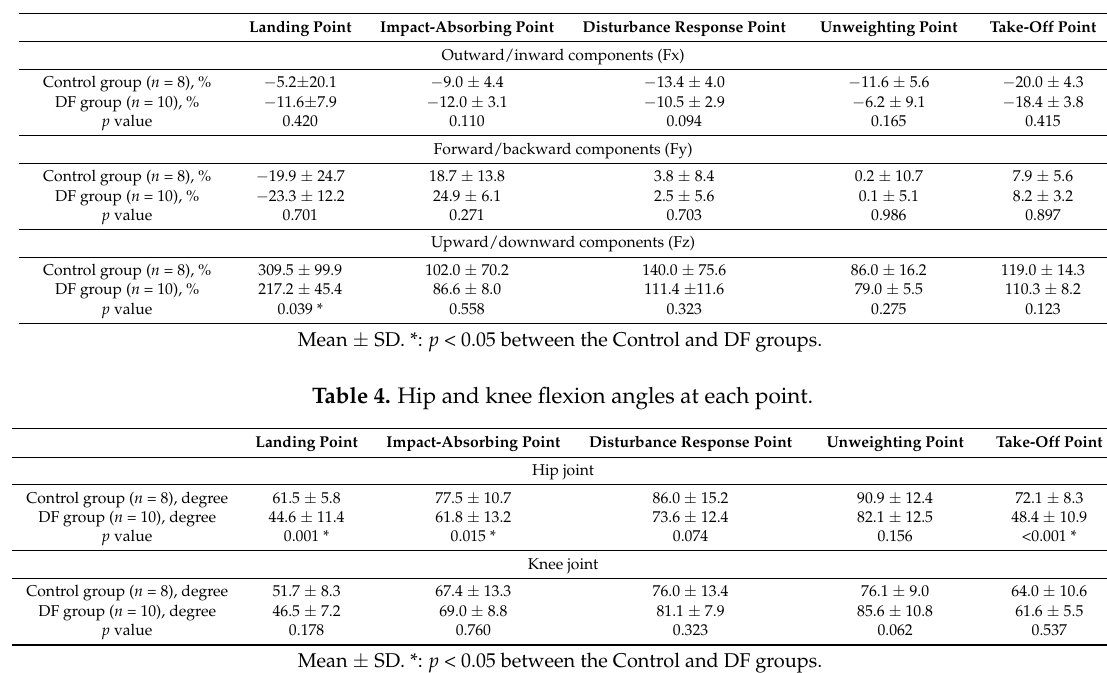
Table 3. The Fx, Fy, and Fz ground reaction force components obtained from the rebound jump.